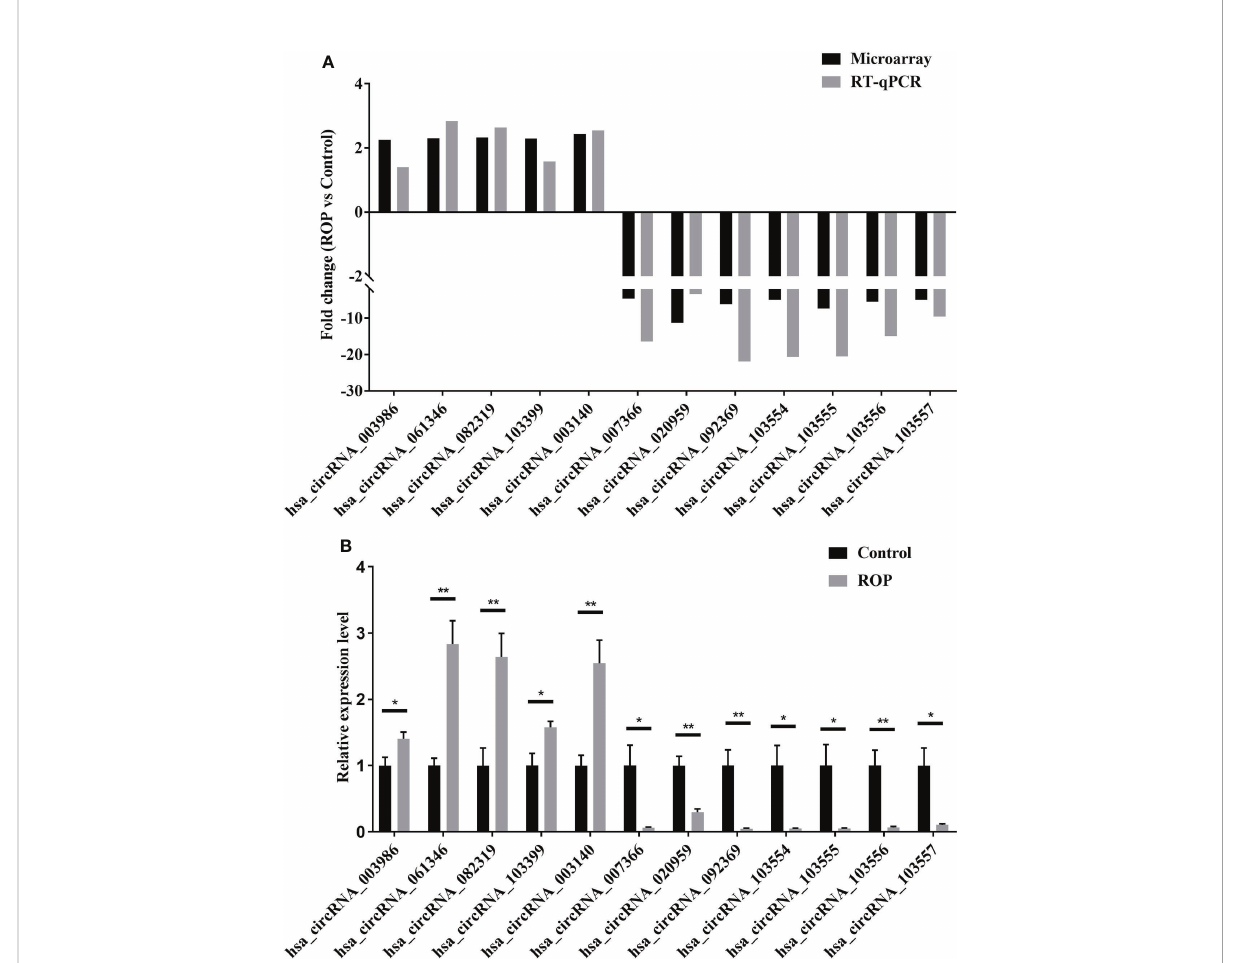
FIGURE 3 Preliminary veri fi cation of twelve differentially expressed circRNAs. (A) Fold changes of these circRNAs by microarray and real-time polymerase chain reaction (RT-qPCR). (B) Relative expression levels of these circRNAs assessed by RT-qPCR. n=5 for each group. ROP, retinopathy of prematurity. *, P<0.05, **,